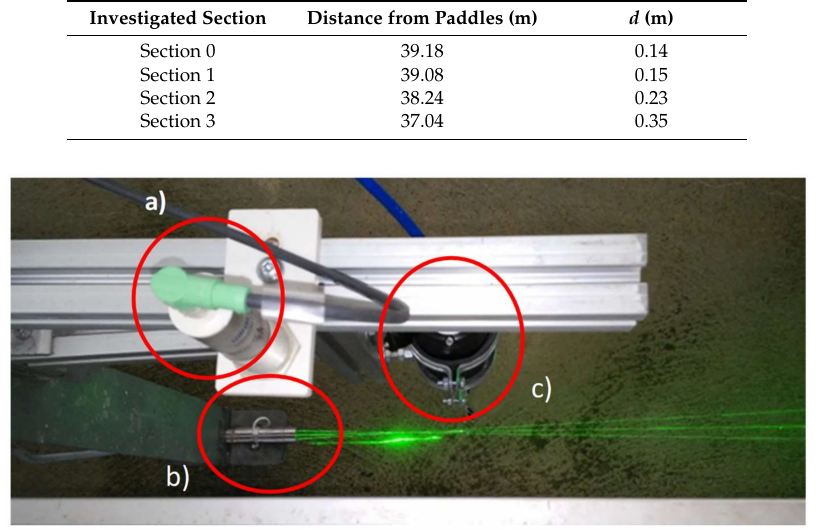
Figure 3. Top view of the measurement instruments: ( a ) ultrasound probe; ( b ) LDA and ( c ) ADV. The ADV and the LDA measurement volume are vertically